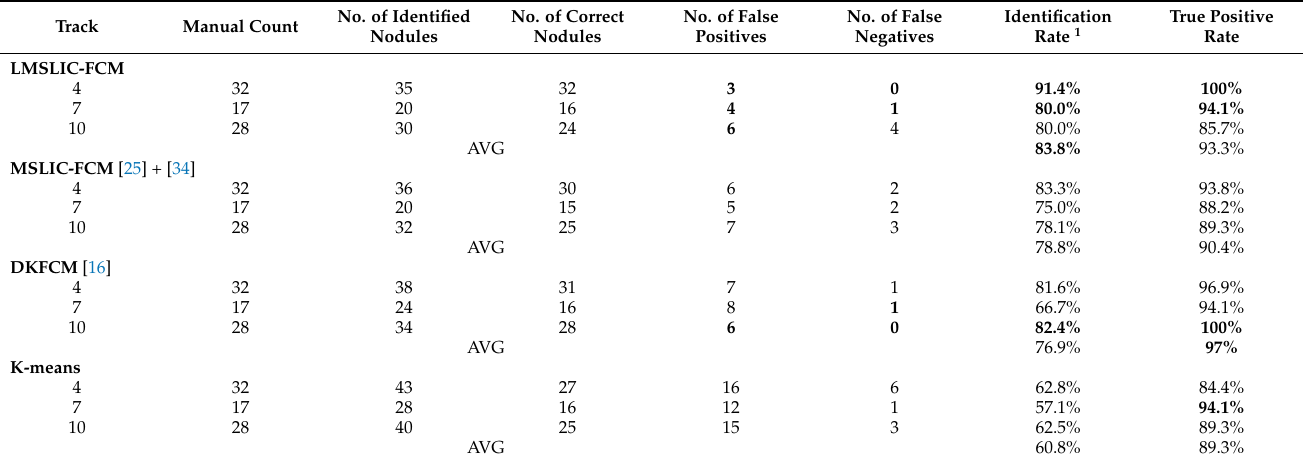
Table 1. Experimental